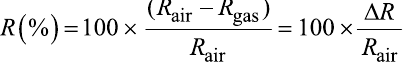
ciable shift is found in the D and G peaks. The 2D peak does not change as well, while the shape is compatible with the pres- ence of several layers in the GO flakes. However a net increase of the increased number of defects due to the presence of Cs +